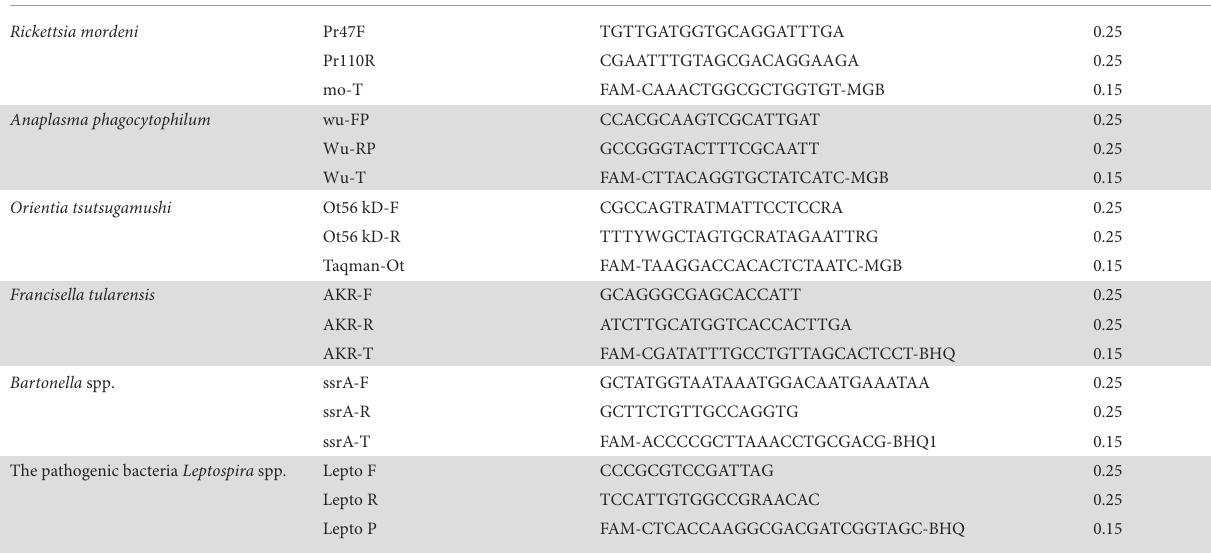
TABLE 2 Primers and probes for testing bacterial and viral pathogens in